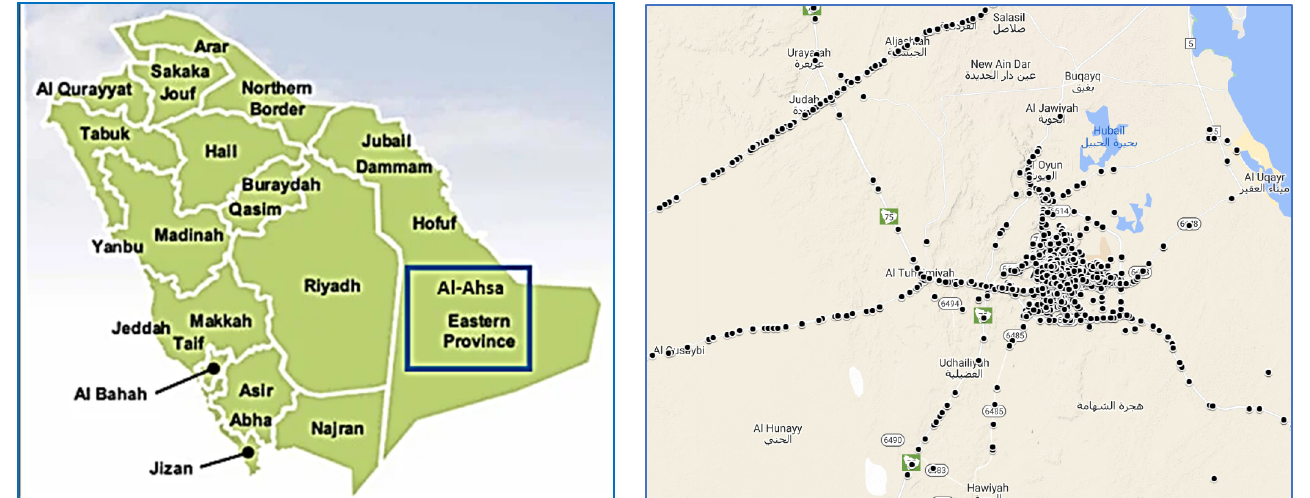
Figure 1. Study area and crash sites in Al-Ahsa between 2015 and 2018. (adopted from [63]).